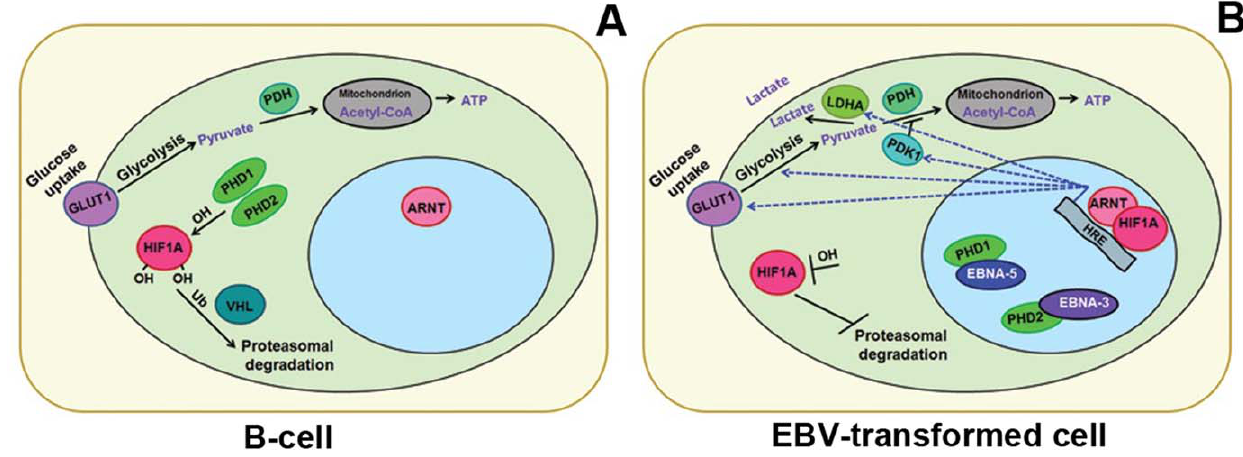
Figure 7. Schematic view on the role of HIF1A in EBV-infected B-cell. A – HIF1A is hydroxylated by the PHDs under normoxic conditions. The hydroxylated HIF1A is recognized by the VHL, E3 ubiquitin ligase, and HIF1A is degraded on proteasomes in activated B-cells. B – Upon EBV infection, EBNA-3 and EBNA-5 bind to PHD2 and PHD1, respectively, and inhibit HIF1A hydroxylation and degradation. The stabilized HIF1A translocates to the nucleus, forms a heterodimer with ARNT and transactivates genes such as GLUT1 , PDK1 and LDHA . This results in conversion of pyruvate to lactate, i.e., aerobic glycolysis.